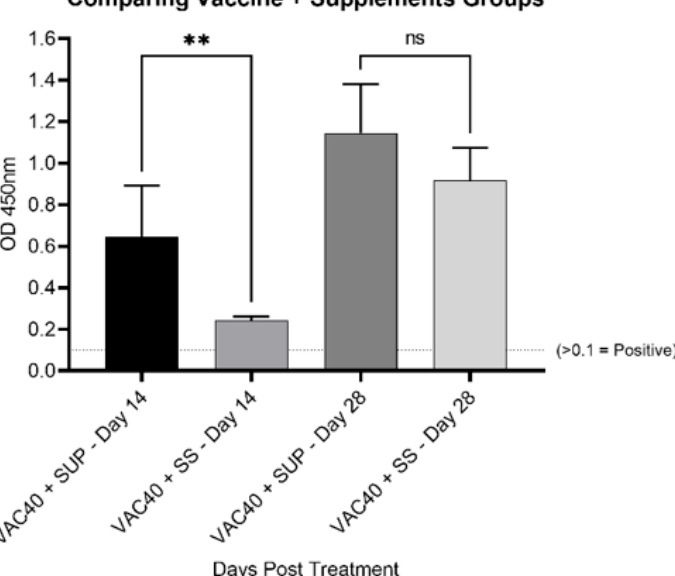
Figure 2. Comparing IgG response for commercial selenium supplement and sodium selenite 14 and 28 days post treatment. Unpaired t -tests to compare the differences for commercial selenium supplement (VAC40 + SUP) and sodium selenite (VAC40 + SS) were performed using GraphPad Prism v.9. The dashed line indicates the cut-off value for IgG positive OD 450nm values. ** p < 0.001.